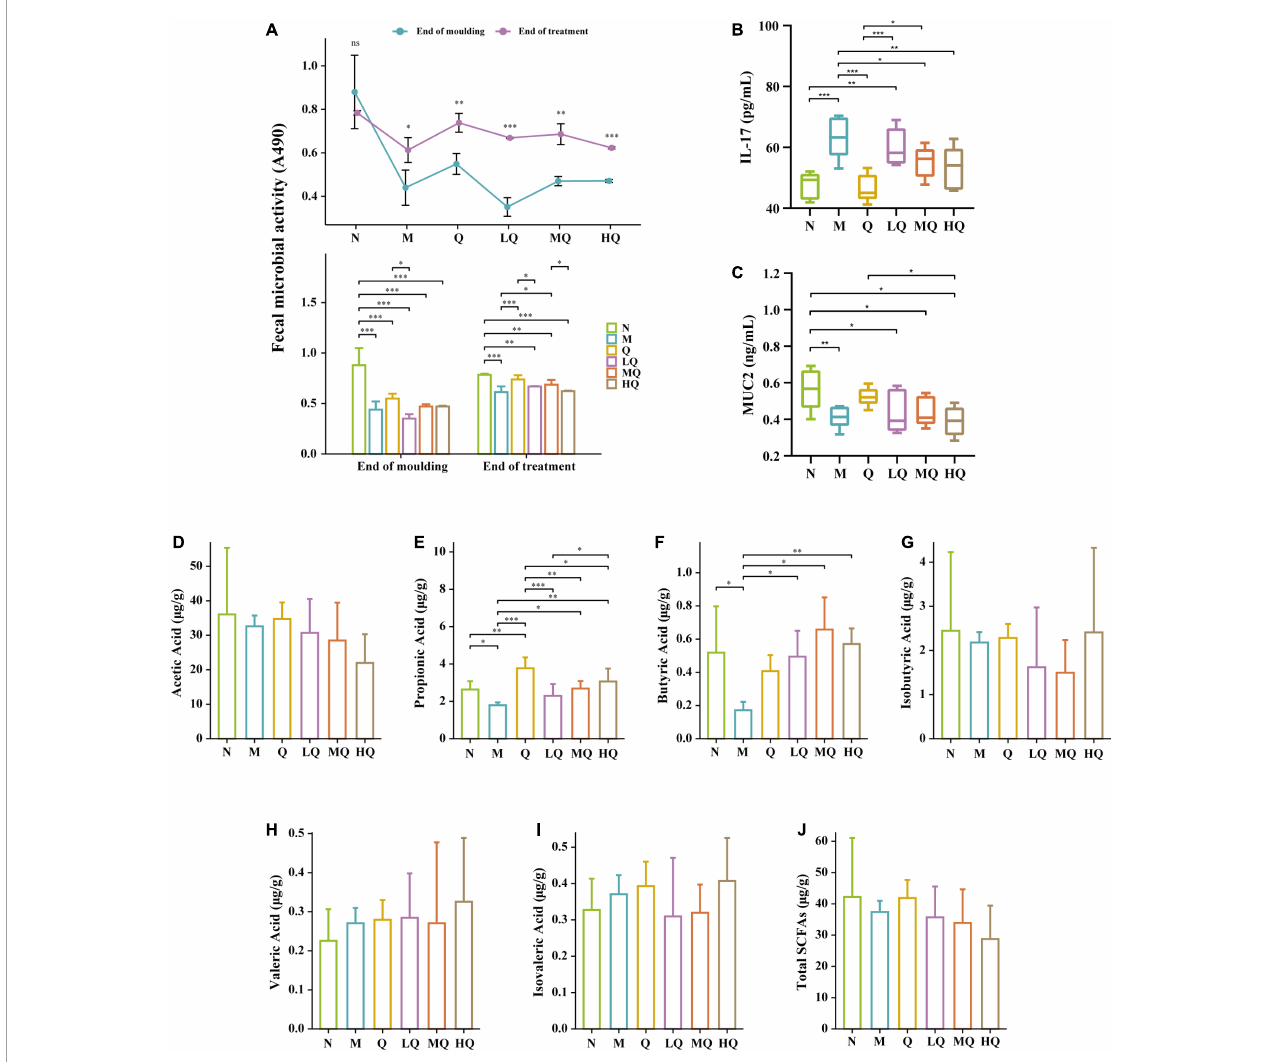
FIGURE3 Effect of different sucrose dose on the fecal microbial activity (A) , IL-17 content (B) , mucin 2 (MUC2) content (C) , and short-chain fatty acids (SCFAs) (D–J) of mice with antibiotic-associated diarrhea (AAD) intervened by Qiweibaizhu powder (QWBZP). ∗ p < 0.05; ∗∗ p ≤ 0.01; ∗∗∗ p ≤